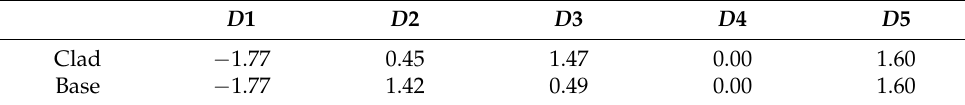
( b ) Figure 20. Crack propagation path in ( a ) 3by3 model at 𝜀(cid:4662) (cid:3036) = 1 s − 1 and displacement level of d = 0.36 mm and ( b ) 6by6 model at 𝜀(cid:4662) (cid:3036) = 4 s − 1 and displacement level of d = 0.24 mm. The right side of the cross-sections presents the outer wall of the rings. The direction of the fracture path is a function of the thickness of layers. Delamination-like behavior or crack branching occurs at the interface in the 3by3 model with a sharp change in the angle